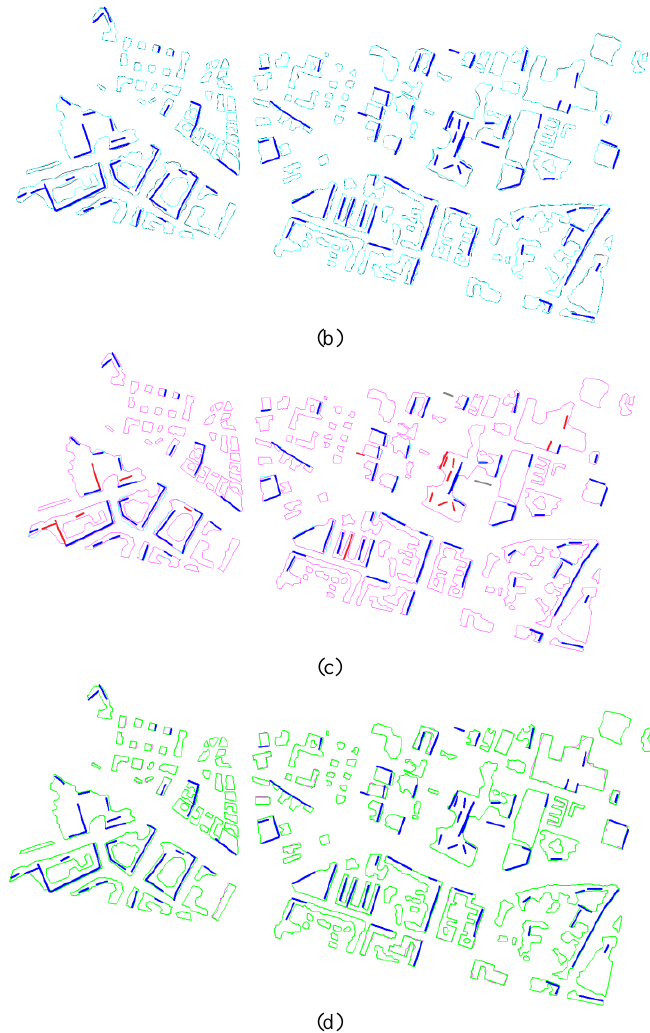
Figure 3: Footprint reconstruction results: (a) Clustered (or segmented) building points. Black polygons V surrounding alpha individual segmented building points are the initial coarse boundary/outline obtained using alpha shapes algorithm; (b) Refined (cyan) polygons V obtained after applying recursive angular deviation approach together with 2-D reconstructed façades refined depicted in blue are overlaid onto alpha shape polygons V ; (c) Façades are then incorporated to the refined polygons from (b) alpha depicted in magenta color, symbolized as V . Façades either identified as P  or having condition C 1 in not satisfied depicted facadefused in red while façades not associated to any building polygon (i.e., case 1) are depicted in gray. Both red and gray façades are not utilized during the Façade-Polygon fusion process; (d) Final rectilinearized polygons V obtained after adding rectilinear final constraints.